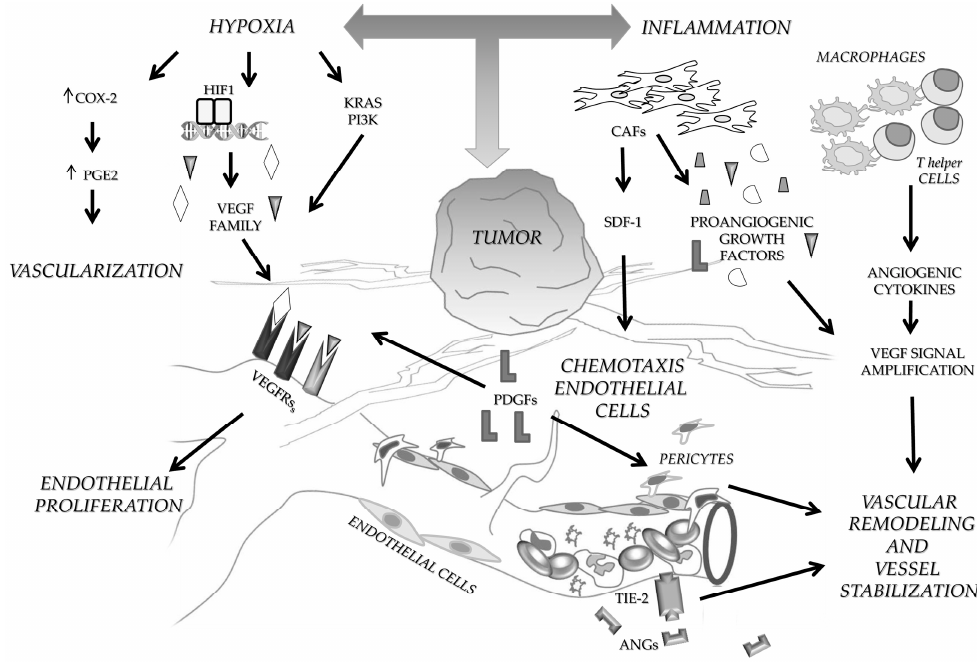
Figure 1. Schematic representation of the main molecular factors and events involved in angiogenesis during CRC progression. Hypoxia and inflammation are indicated as main driver events that through the interplay between tumor and normal associated cells enrich the tumor microenvironment with angiogenic growth factors. Abbreviations: cyclooxygenase (COX-2); prostaglandin-E2 (PGE2); GTPase KRas (Ki-Ras); phosphatidylinositol 3-kinase (PI3K); hypoxia-inducible factor 1 (HIF) 1; vascular endothelial growth factor receptors (VEGFRs); platelet derived growth factors (PDGFs); cancer associated fibroblasts (CAFs); stromal cell-derived factor 1 (SDF-1); angiopoietins (ANGs); tyrosine-protein kinase receptor TIE-2 (TIE-2).